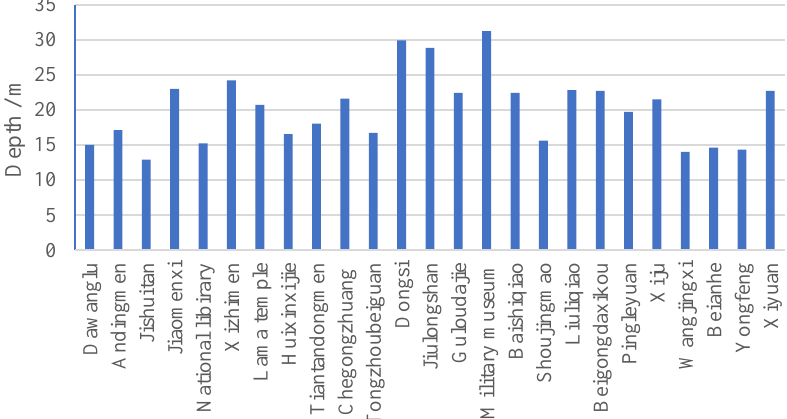
Figure 1. Depth of the subway stations in Beijing.